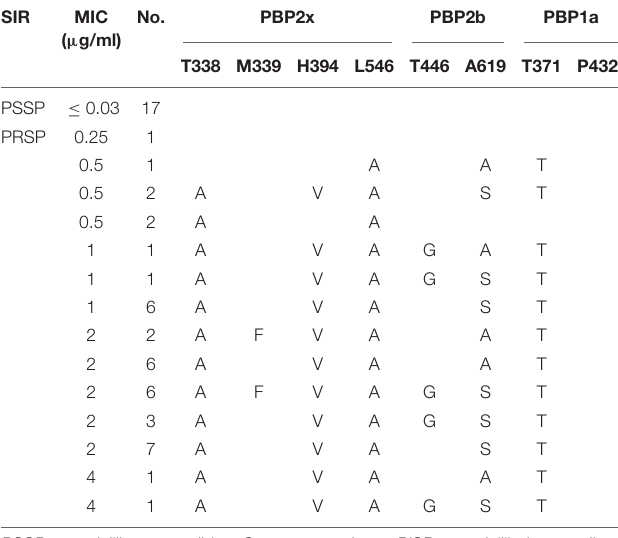
TABLE 5 | Association of penicillin susceptibility and variations of conserved motifs forming or surrounding active penicillin-binding proteins (PBPs) binding sites in PBP2x, PBP2b and PBP1a in S. pneumoniae isolates from